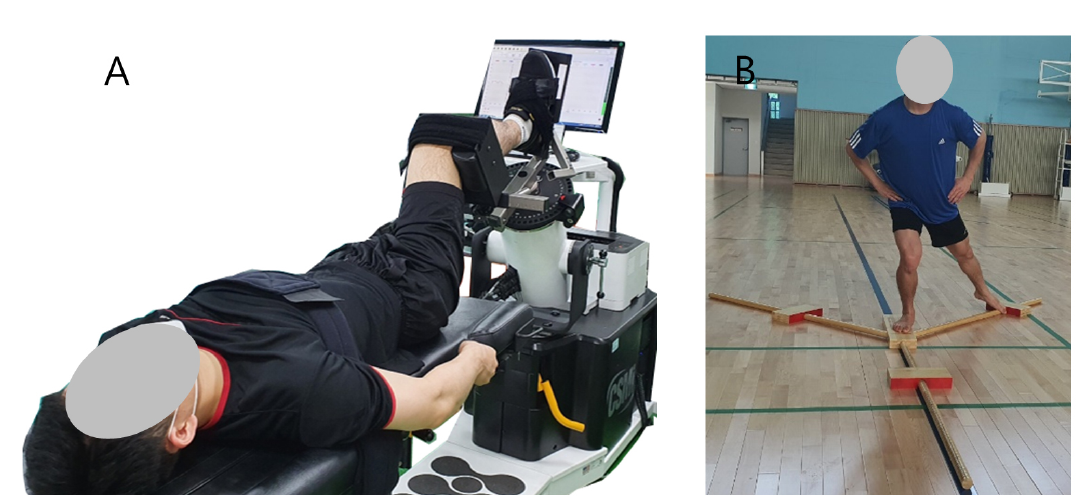
Fig. 1. Isokinetic strength test and Y-balance test. (A) Isokinetic strength test. (B) Y-balance test.